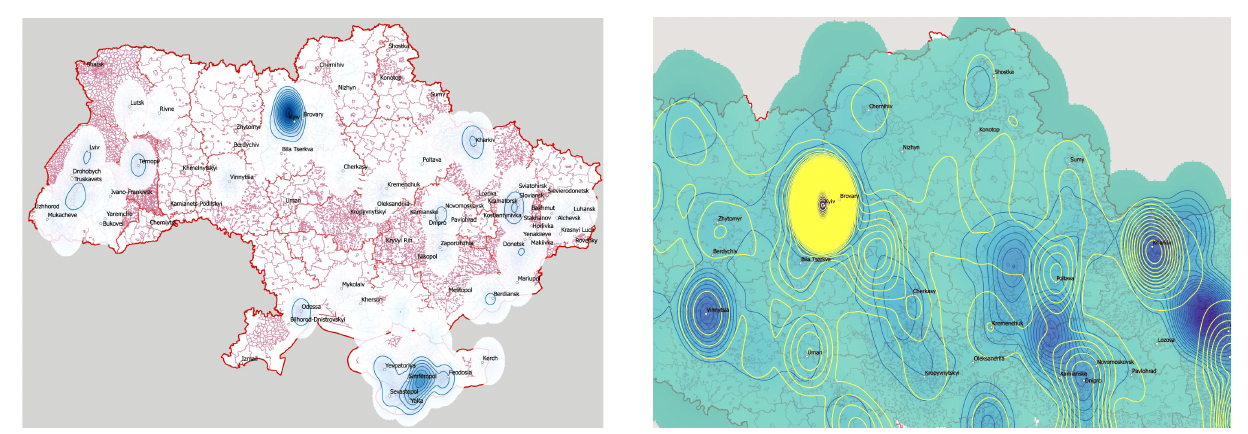
Figure 9. A heatmap (the distribution of tourist accommodation on the territory of Ukraine)